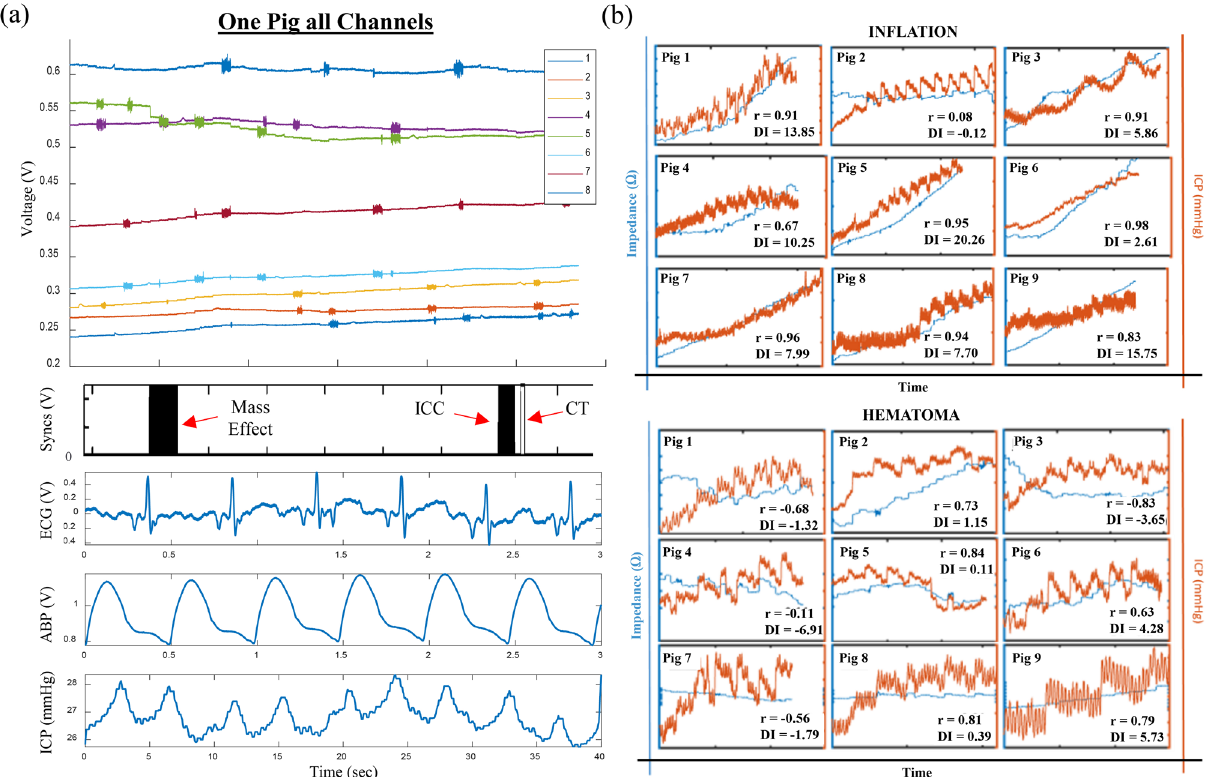
Figure 4. Initial differences in impedance behavior between inflation and hematoma. ( a ) All collected traces from one pig: eight impedance channels and all Biopac physiologic signals. Sync Traces show linear stage activation for each Mass Effect injection, spaced 5 min apart. Each ICC check occurs 2 min following Mass Effect. CT acquisition followed ICC, with precise timing of the manual acquisition captured through a custom sync button. All Biopac signals are shown in seconds. High noise sections on impedance channels are associated with data recorded during active acquisition of a CT and these artifacts are removed prior to data analysis, as described in Supplementary Method 1. ( b ) ICP (orange) and impedance (blue) for all animals and both injuries across a single electrode. Pearson’s correlation coefficients and DI represented for each animal for the presented trace. Impedance y-axes are normalized within each animal between injury